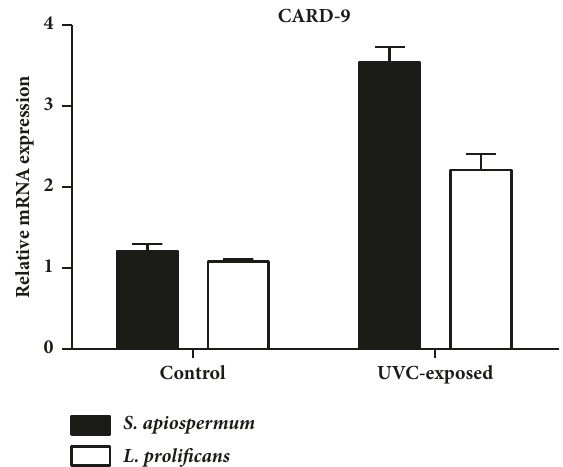
Figure 7: CARD-9 mRNA expression in S. apiospermum CBS 117410 and L. prolificans CM324 after 15 min of UVC exposure compared with controls. Gene expression was calculated using the 2 ΔΔ Ct method. Triplicate experiments were carried out to derive mean ± standard deviation. The CARD-9 expression levels were normalized to 𝛽 -tubulin